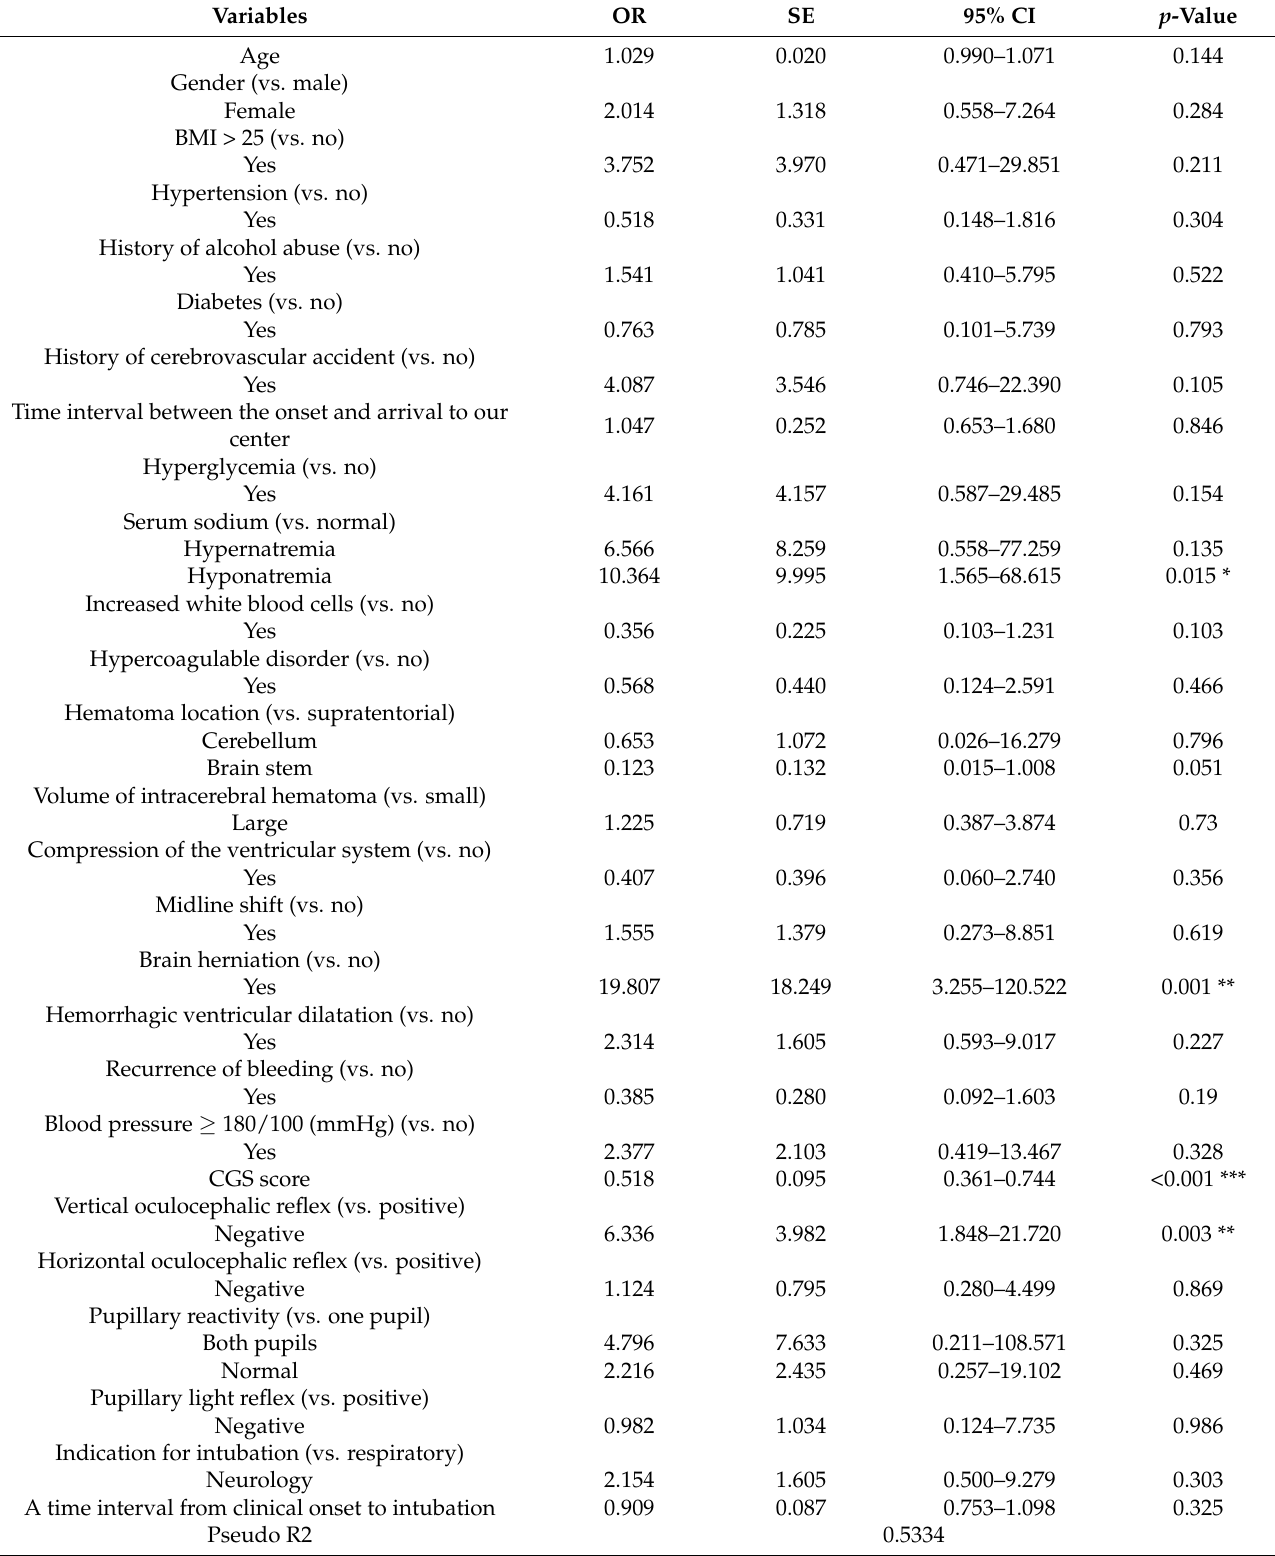
Table 5. Multivariate logistic regression analysis of mortality risk factors for patients with intracranial hemorrhage undergoing endotracheal